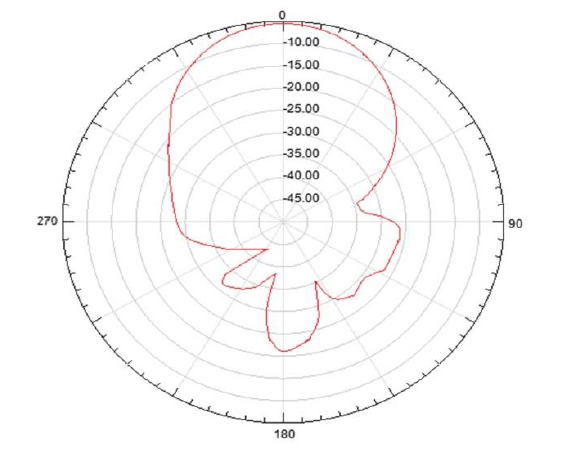
Fig. 7. The frequency dependence of the input antenna reflection coefficient